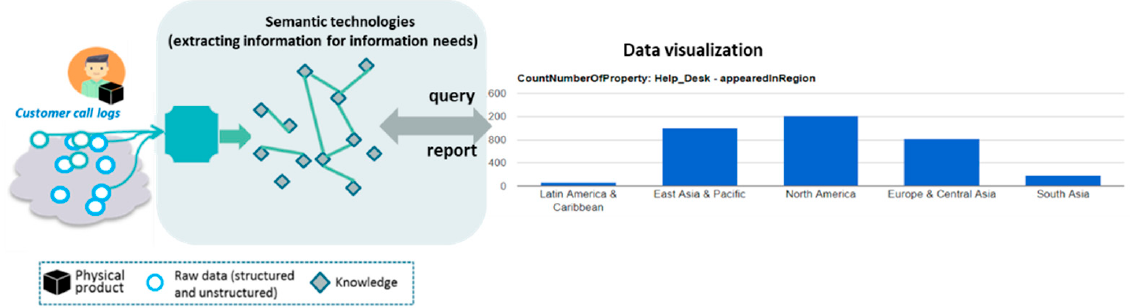
Figure 15. Example process from data to knowledge for the design activity.